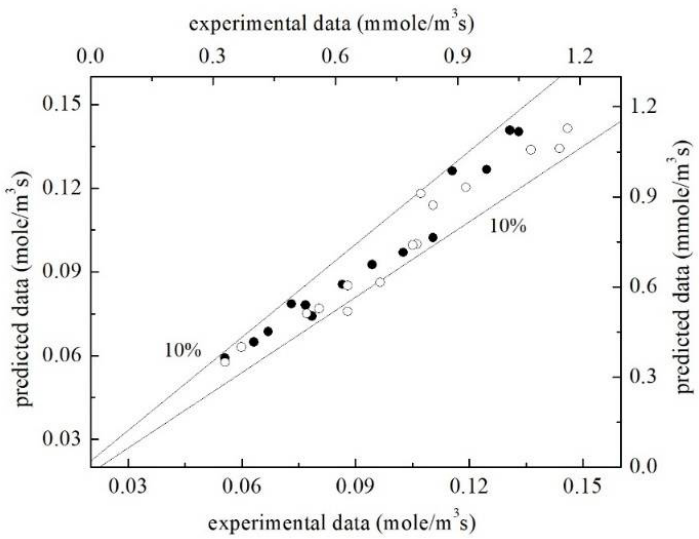
Figure 10. Regression of literature data and Comparison with this study. ( • : dada in this study corresponding to the left and upper axes; ◯ : data from literature [13] corresponding to the right and bottom axes).